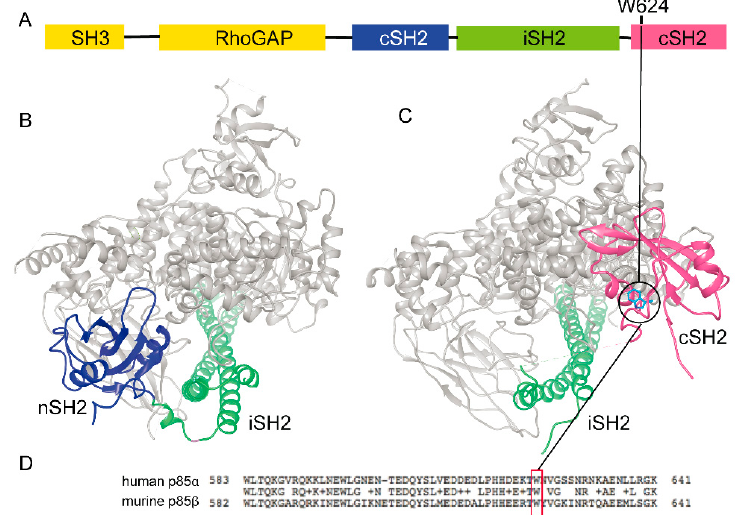
Figure 4. Crystal structures showing interaction of the p110 isoforms with the p85 isoforms in human and mouse PI3K. ( A ) Domain organization of p85 α . ( B ) Available crystal structure (PDB ID 4L1B) of human p110 α isoform with catalytic activity (grey) complexed with nSH2 (blue) and iSH2 (green) domains of human p85 α ; ( C ) available crystal structure (PDB ID 2Y3A) of mouse p110 β in complex with iSH2 (green) and cSH2 (pink) domains of mouse p85 β . ( D ) Alignment of the cSH2 domains of the human p85 α and mouse p85 β ; homology is shown in the middle: W624 of the human p85 α protein is conserved and corresponds to the W616 of the mouse p85 β protein (red box in D). Regrettably, only the crystal structure of human p110 α in complex with nSH2 and iSH2 domains of p85 α is available (PDB ID 4L1B, Figure 4B). Hence, we explored the possible role of the amino-acid residue homologue to the W624 in mouse p85 being available in the crystal structure of mouse p110 β isoform in complex with iSH2 and cSH2 domains of mouse p85 β isoform (PDB ID 2Y3A, Figure 4C). Structure superimposition showed that mouse p85 β shares common folds with the human p85 α counterpart. Sequence alignments demonstrated that human p85 α and mouse p85 β display 73% homology and 59% identity, whereas human p110 α and mouse p110 β sequences have 57% homology and 40% identity. According to sequence alignment (Figure 4D), the W624 in the human p85 α corresponds to W616 in the mouse cSH2 domain of p85 β . These data analyses showed that the W616